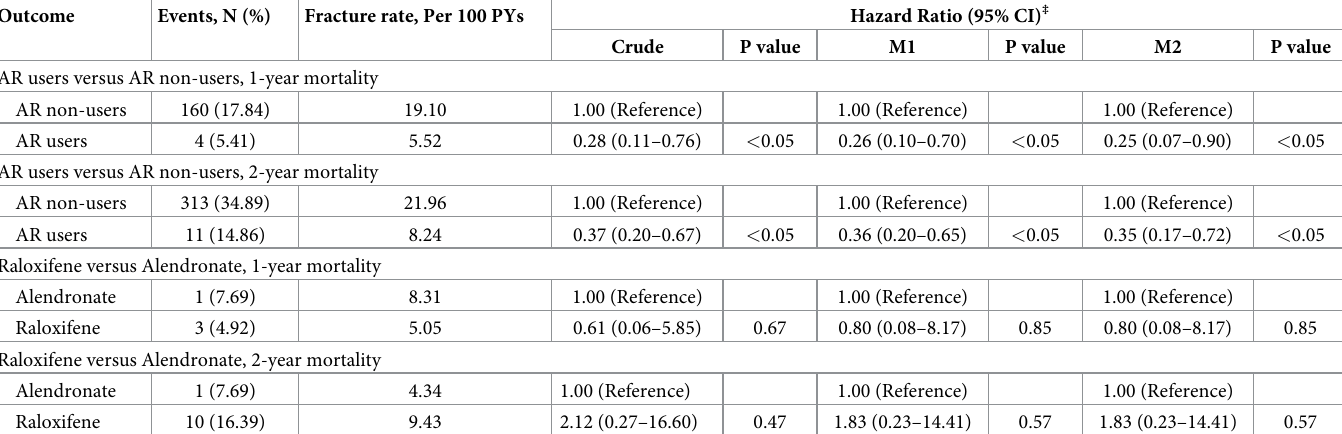
Table 3. 1-year and 2-year mortalities of AR non-users versus users and raloxifene versus